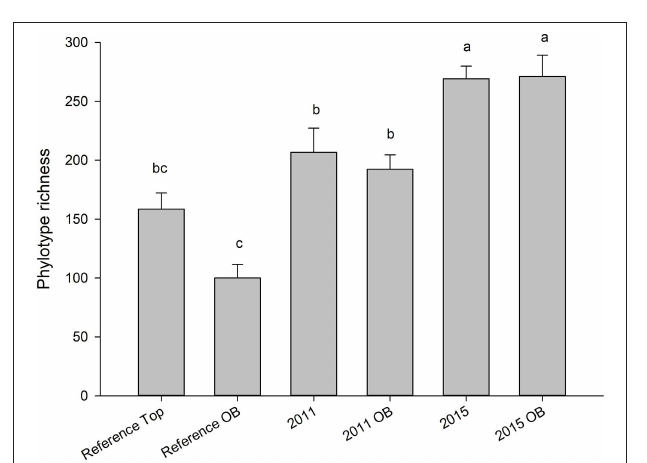
FIGURE 5 | Average (SE) number of fungal phylotypes in sites receiving both standard topsoil transfer and overburden (OB). Letters indicate significance at p < 0.05 (Tukey). Values represent a mean of five samples. Ref indicates soils taken from an adjacent, undisturbed “reference” site. soils which was dominated by Coniochaeta (tree pathogens).